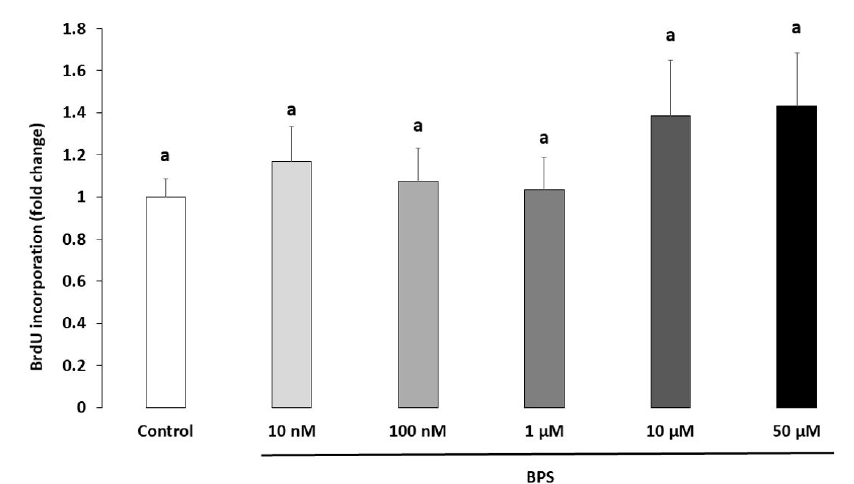
Figure 2. E ff ect of Bisphenol S (BPS) on human granulosa cell (HGC) cellular proliferation. HGC underwent 48-h culture with 10 µ M bromodeoxyuridine / 5-bromo-2’-deoxyuridine (BrdU), in the presence or absence of BPS (10 nM, 100 nM, 1 µ M, 10 µ M or 50 µ M). The cell proliferation was normalised to the control condition of each culture. The results are expressed as the mean ± standard error of the mean (SEM) of five independent experiments with four replicates per condition. Bars with di ff erent superscripts indicate a significant di ff erence ( p ≤